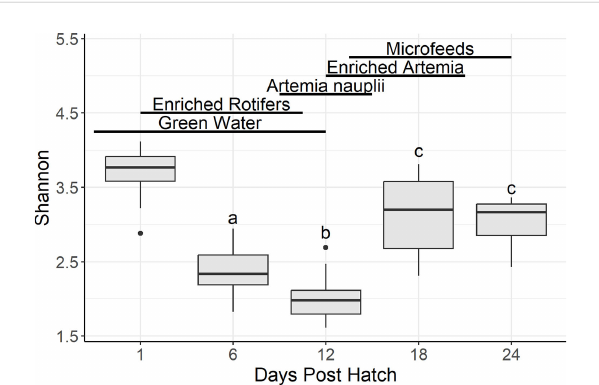
FIGURE 2 Boxplots summarizing water Shannon diversity by days post